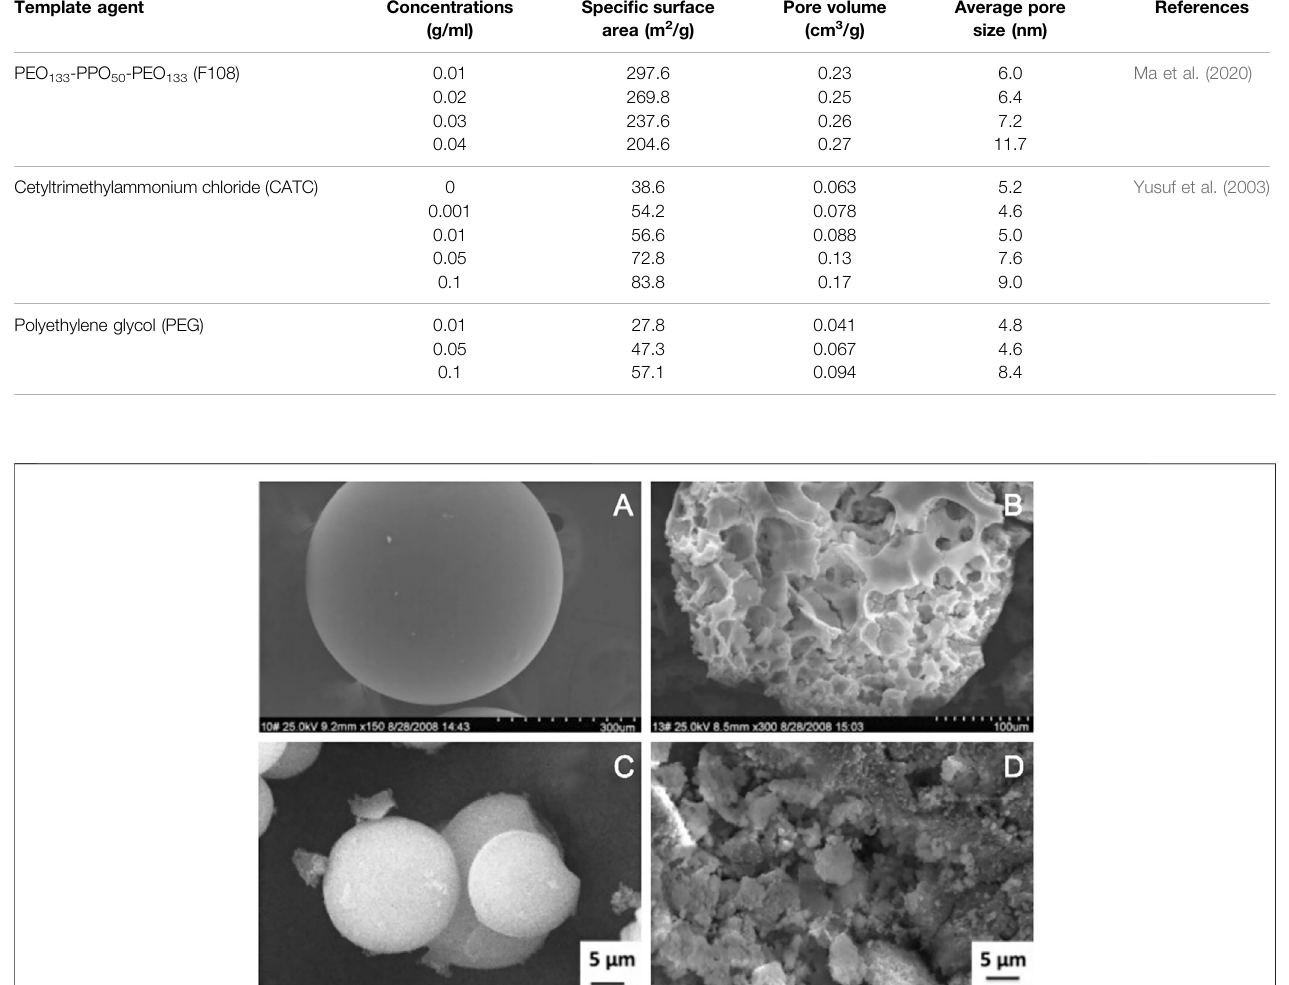
Frontiers in Chemistry |